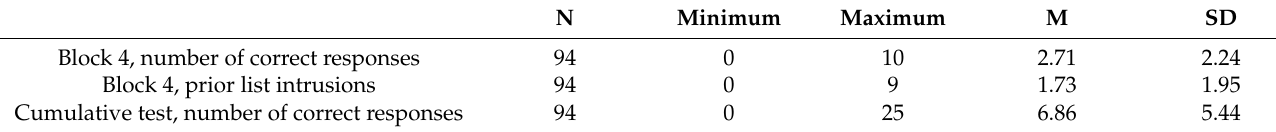
Table A1. Number of correct responses and prior list intrusions. N